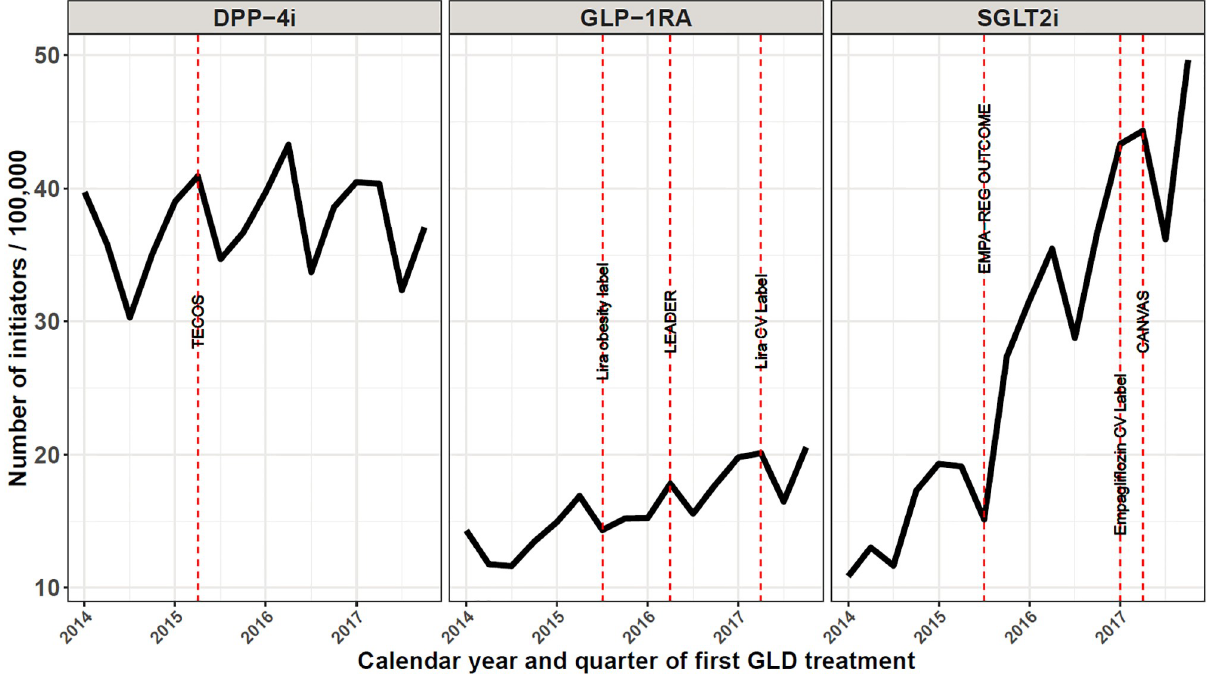
Fig 1. Quarterly number of initiators of DPP-4i, GLP-1RA, and SGLT2i in Denmark, 2014–2017. DPP-4i: dipeptidyl peptidase-4 inhibitor; GLP- 1RA: glucagon-like peptide-1 receptor agonists; SGLT2i: sodium-glucose cotransporter 2 inhibitors; TECOS: Sitagliptin (DPP-4i) showed non- inferiority to placebo [35]; Lira obesity label: Liraglutide 3 mg launched as treatment for obesity; EMPA-REG OUTCOME: empagliflozin showed CV and CV/all-cause mortality benefits [10], LEADER: liraglutide showed CV and CV/all-cause mortality benefits [12]; CANVAS: canagliflozin showed CV benefits